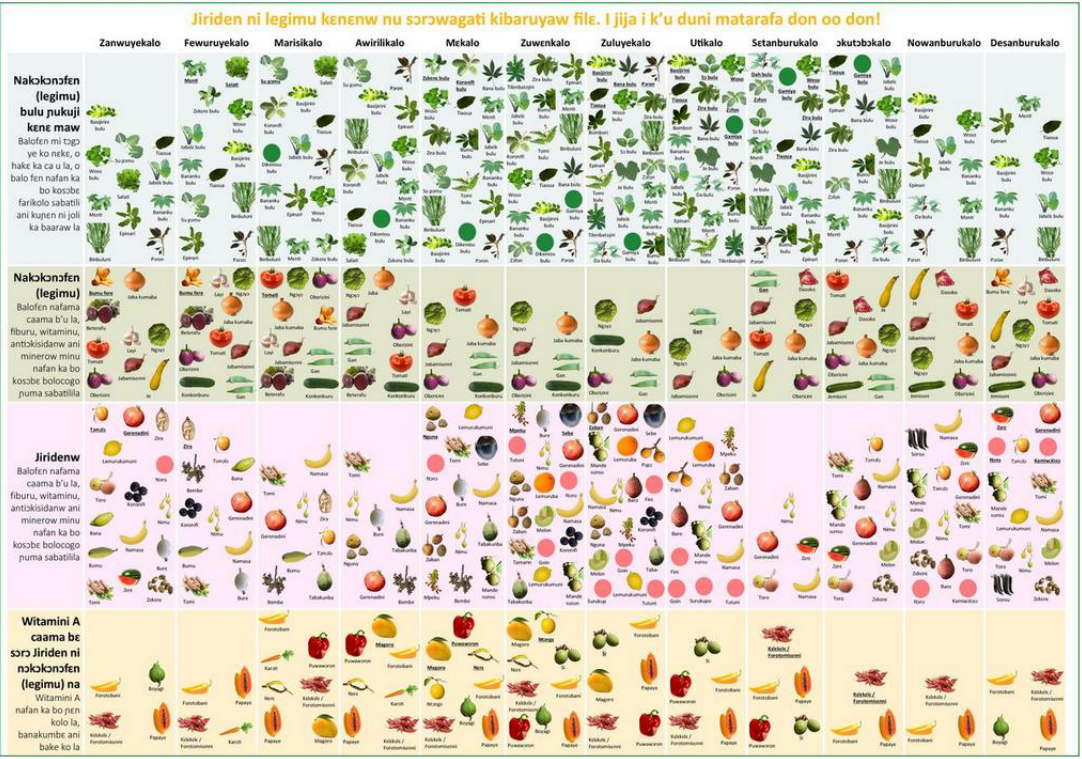
Figure 3. Seasonal calendar of fruits and vegetables in the Segou region, Mali, in the local language. Source: Bioversity International. [41,101]. Table 4. Recipes and novel food products using orphan crops fonio ( Digitaria exilis ) and Bambara groundnut ( Vigna subterranea ) in nutrition interventions carried out by Bioversity and the Institut d’Economie Rurale (IER) in Mali. Fonio Bambara Groundnut Covafo : a complementary food made with Bambara groundnut, fonio, wheat flour Fonio with vegetables and dried fruits Fonio with amaranth and jute mallow